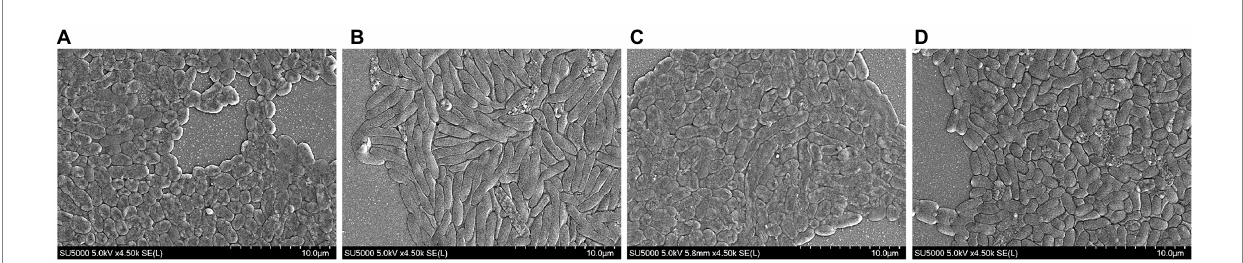
FIGURE 2 SEM of Vibrio parahaemolyticus under different treatment conditions. (A) 1/2 MIC Cu 2+ treatment, (B) 1/2 MIC CARB treatment, (C) 1/2 MIC Cu 2+ +CARB treatment, (D) control.